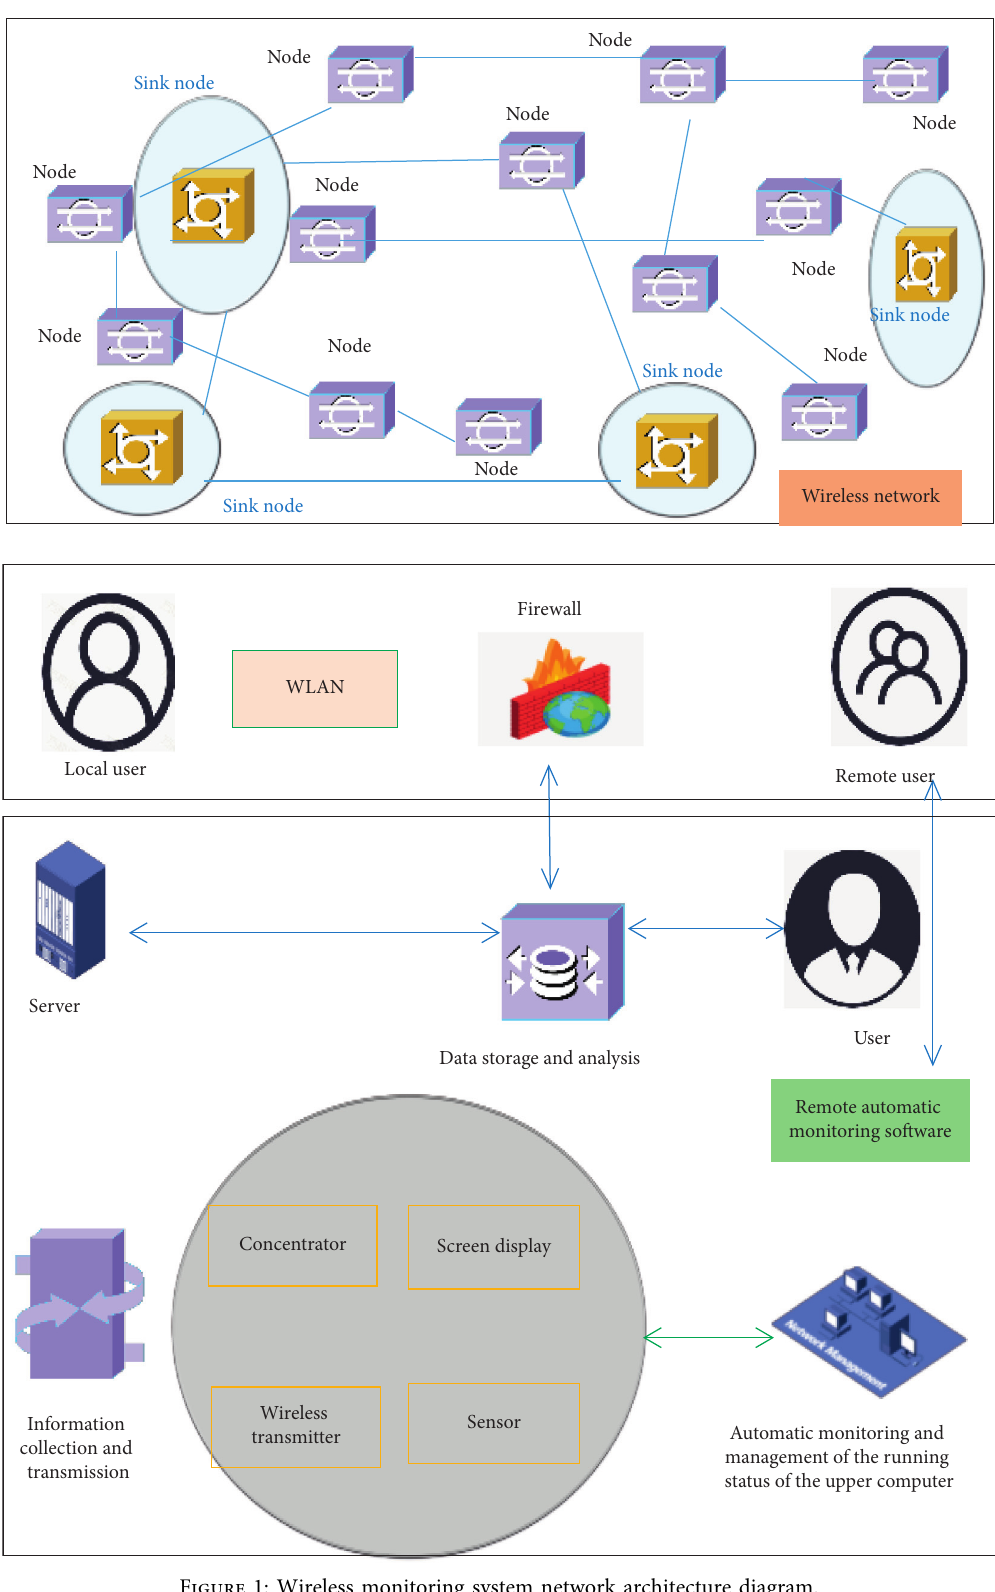
Figure 1: Wireless monitoring system network architecture